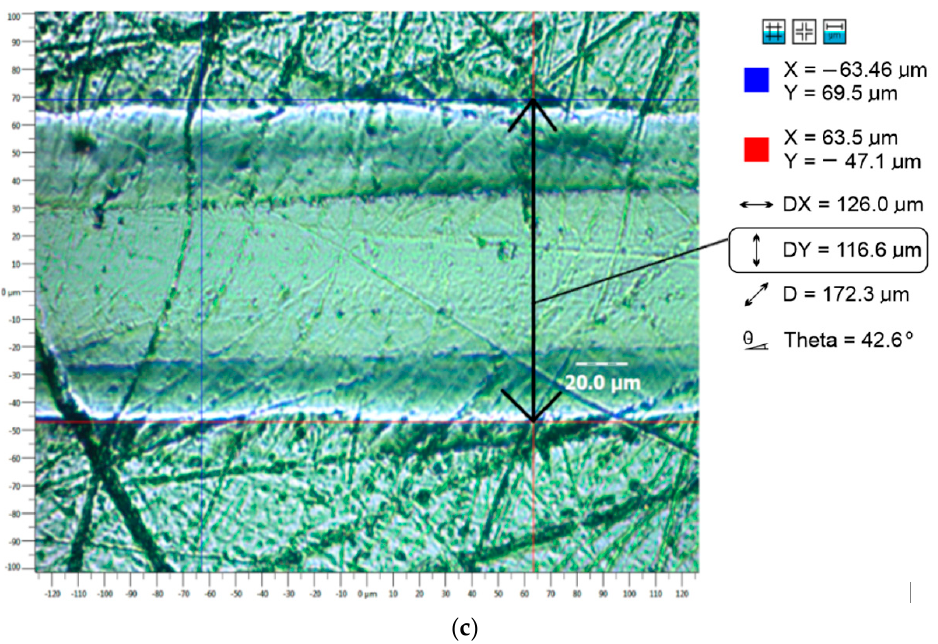
Figure 3. Scratch test and samples used in the test: ( a ) sample in an MCT holder for scratch test; ( b ) the width of sample used in the scratch test; ( c ) and scratch width measurement (SW mic ) using an optical microscope.